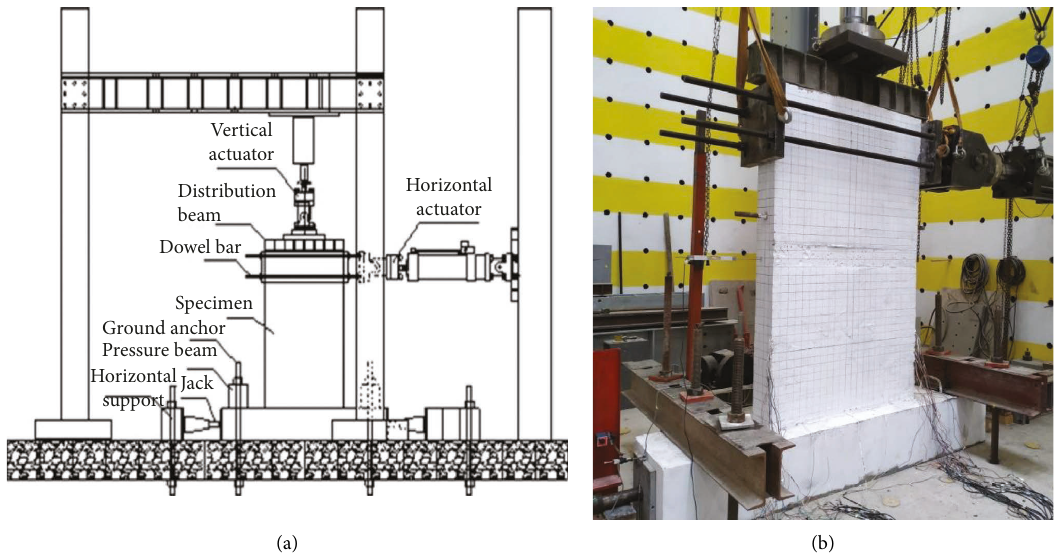
Figure 4: Experimental setup. (a) Schematic. (b) Physical